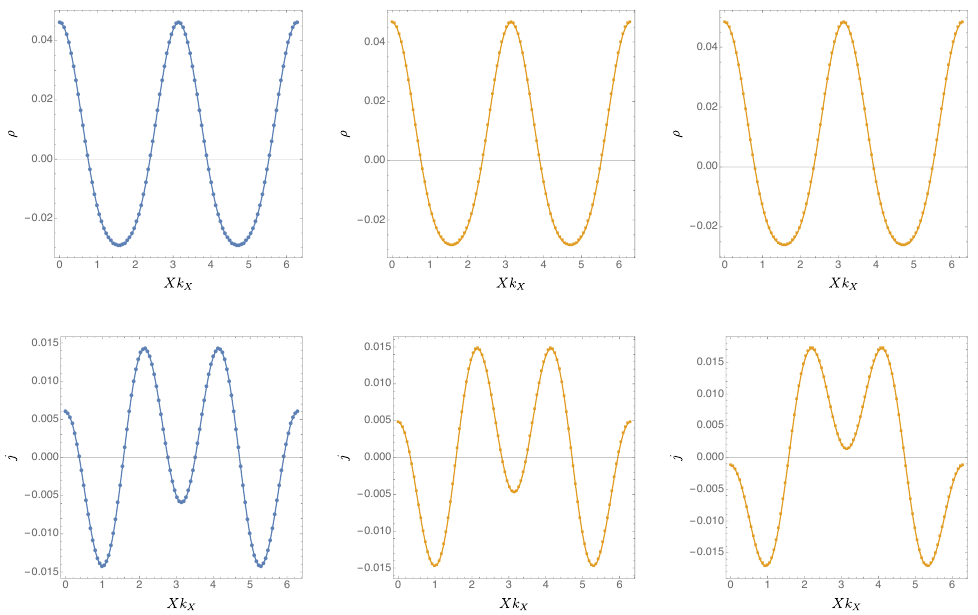
������������������������� Figure 21 . The holographic energy density (top row) and holographic momentum density (bottom row) computed at (cid:12)xed a = 1 : 1008 at three distinct temperatures. From left to right we have T=k X = 0 : 0239 ; 0 : 0477 ; 0 : 0716. ���������������� Figure 22 . The holographic energy density (left panel) and holographic momentum density (right panel) computed for a = 0 : 975 and T=k X (cid:25) 1 :